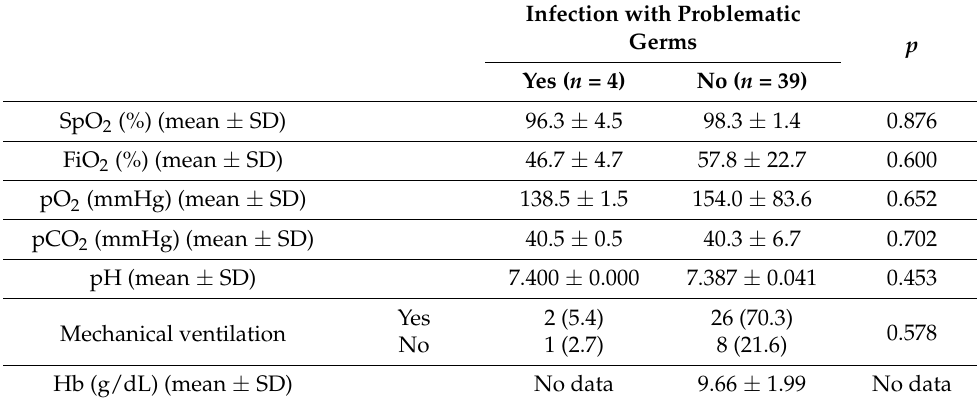
Table 13. Univariate Analysis of Variables from ICU Patients on Infection with problematic